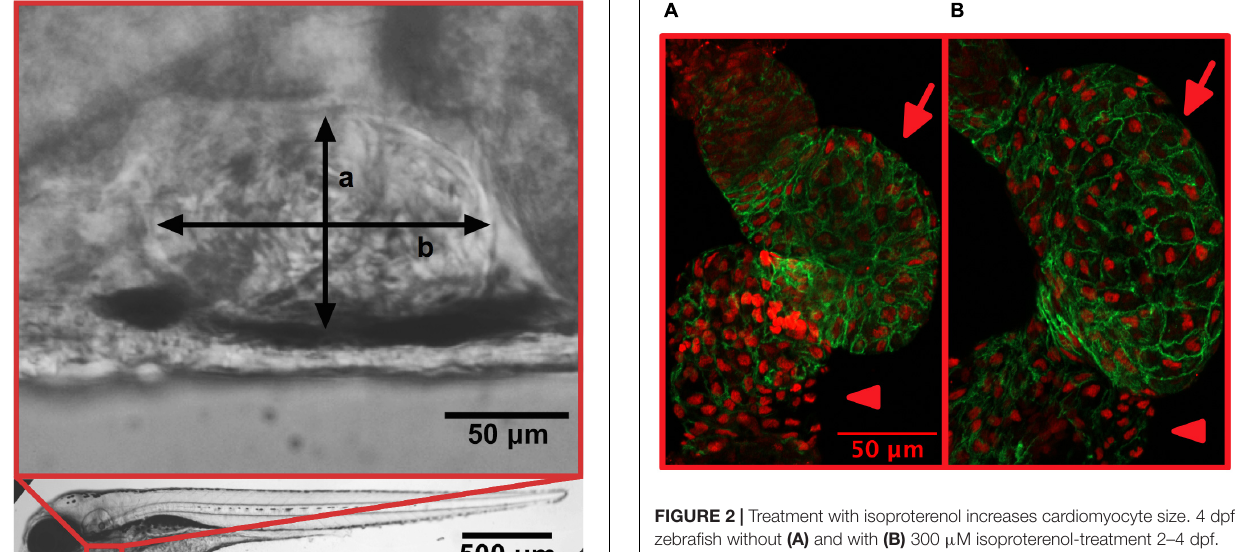
in vivo video-microscopy and echocardiography. This